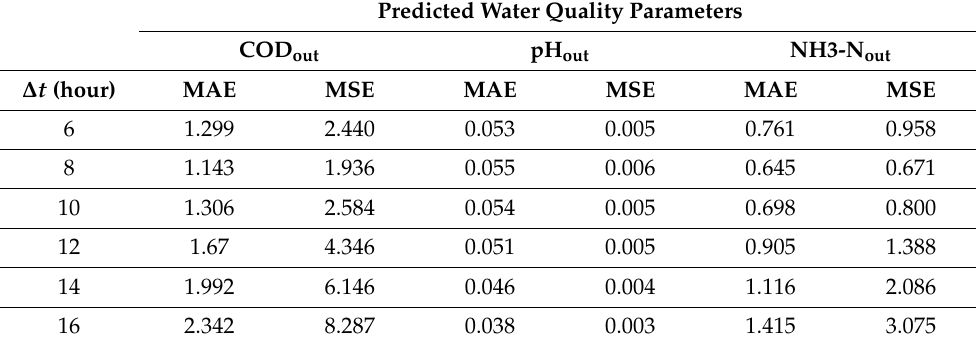
Table 3. The prediction errors of the LMPNet on the output water quality characteristics for different time delays.